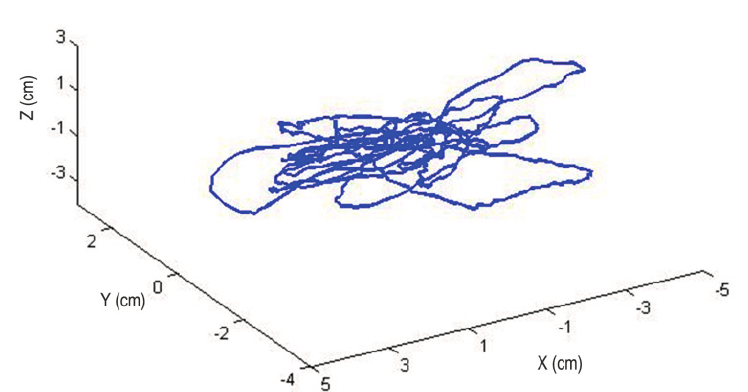
Figure 11. Position error while hovering during 60 s. The RMS value of the position error is 1.54 cm in X , 1.04 cm in Y and 0.92 cm in Z .